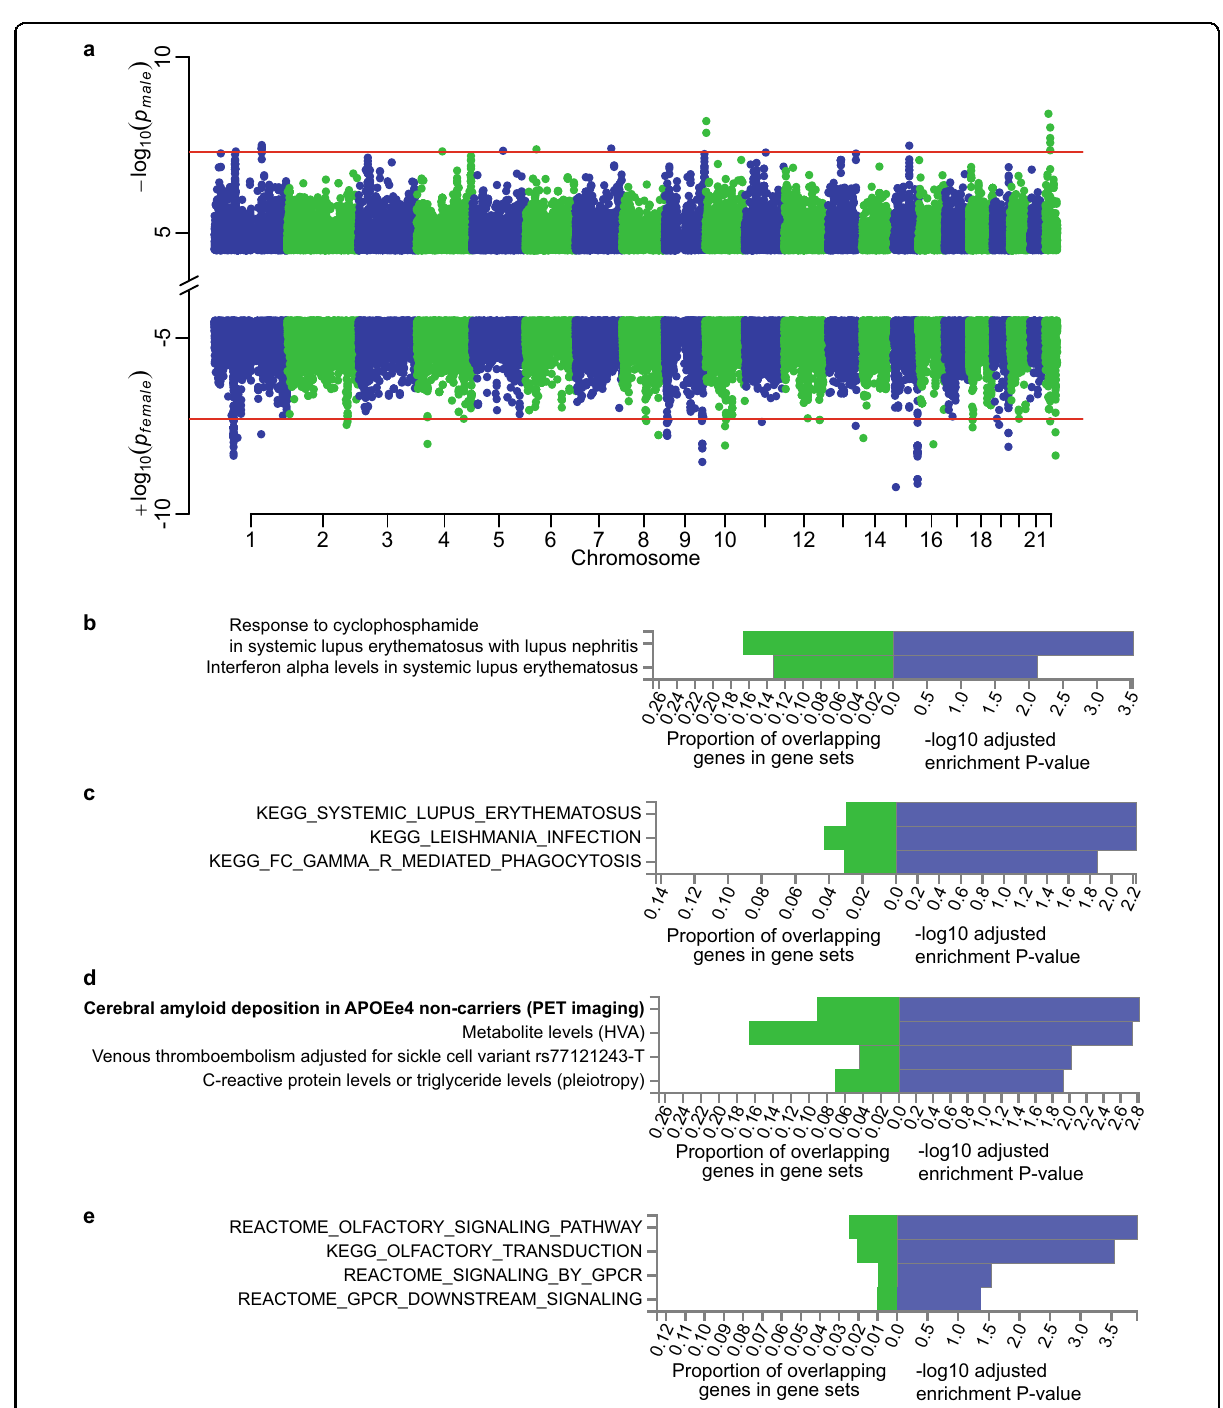
Fig. 3 Gender-speci fi c associations and functional analysis. a Manhattan plot showing the male-speci fi c and female-speci fi c associations for gut microbiome. The red line represents the genome-wide P threshold (5 × 10 − 8 ). b Enriched traits or diseases identi fi ed using male-speci fi c associations mapped in GWAS catalog. c Enriched KEGG, REACTOME, or GO pathways identi fi ed for male-speci fi c associations using FUMA tool. d Enriched traits or diseases identi fi ed using female-speci fi c associations mapped in GWAS catalog. e Enriched KEGG, REACTOME, or GO pathways identi fi ed for female-speci fi c associations using FUMA